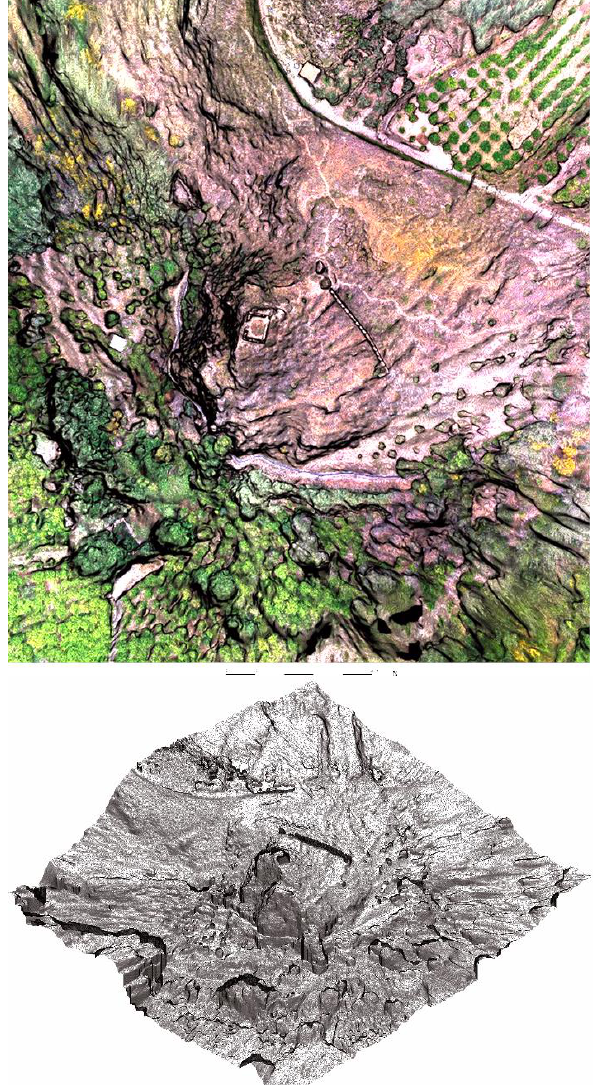
Figure 4. Topographical survey (plan and axonommetric) of the Nasrid tower and fortified enclousure of Lojuela (Murchas,